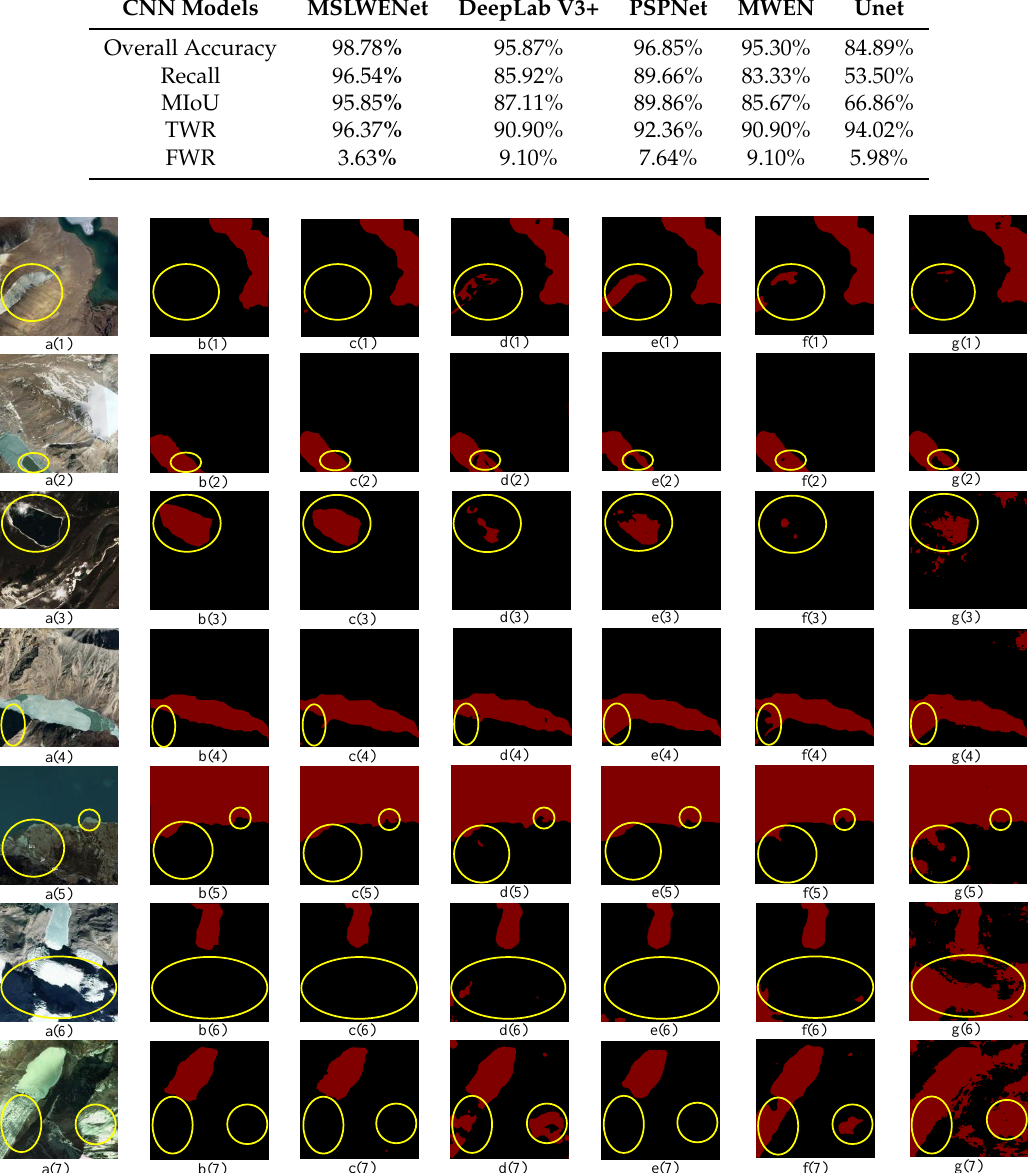
Figure 8. Performance comparison of different models for lake water extraction from small interclass variance regions. ( a(1) – a(7) ) are the raw images in the test set; ( b(1) – b(7) ) are the ground truths to which the raw images correspond; ( c(1) – c(7) ), ( d(1) – d(7) ), ( e(1) – e(7) ), ( f(1) – f(7) ), and ( g(1) – g(7) ) are the extracted results of MSLWENet, DeepLab V3+, PSPNet, MWEN, and Unet,